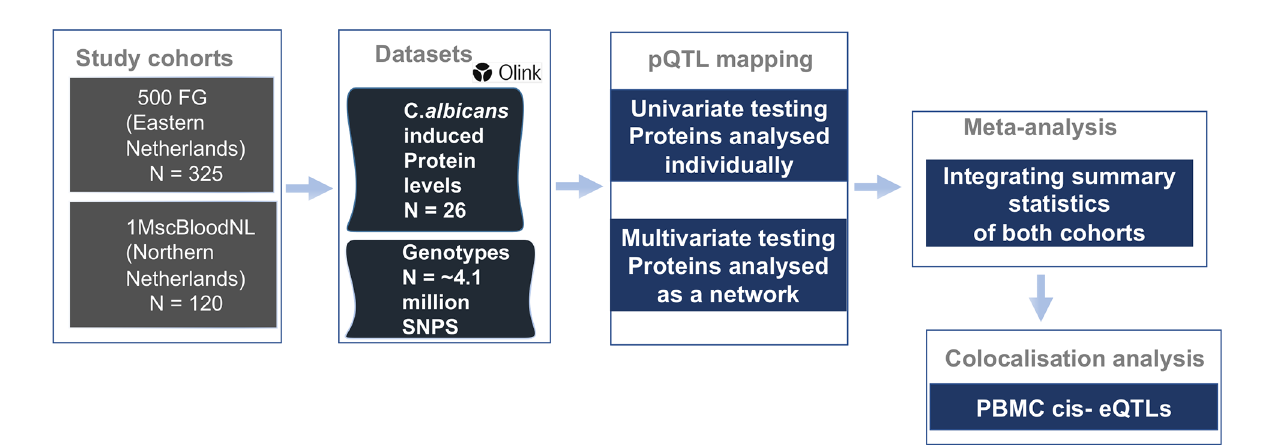
FIGURE 1 Overview of study cohorts, study design and analyses conducted. We performed protein quantitative trait loci (pQTL) mapping utilizing protein abundances and imputed genotypes in two population-based cohorts of individuals of European ancestry. We used two approaches to identify pQTL signals which were meta-analyzed and subsequently colocalized with cell-type speci fi c eQTLs and candidemia GWAS signals to uncover genomic regions of shared